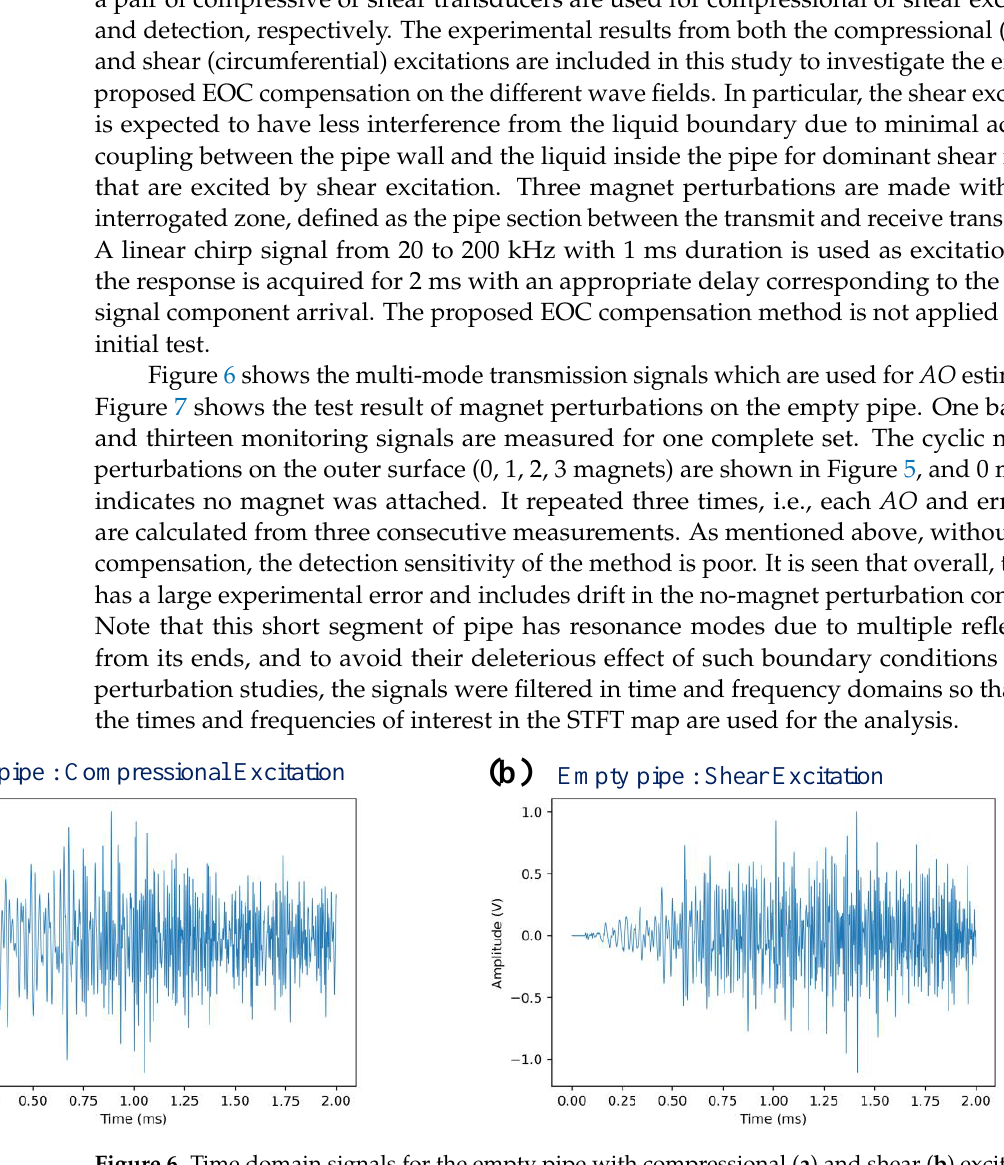
Figure 7. Changes in AO with the different number of magnet perturbations: the empty pipe with ( a ) compressional and ( b ) shear excitations, where no EOC compensation method is applied. Figure 8 shows an example of such time and frequency filtering, improving the AO dependence on magnet perturbation. It is seen that such simple filtering can improve measurement accuracy. Figure 8. Changes in AO with the different number of magnet perturbations: the empty pipe with ( a ) compressional and ( b ) shear excitations. Simple time and frequency filtering lead to improved detection.